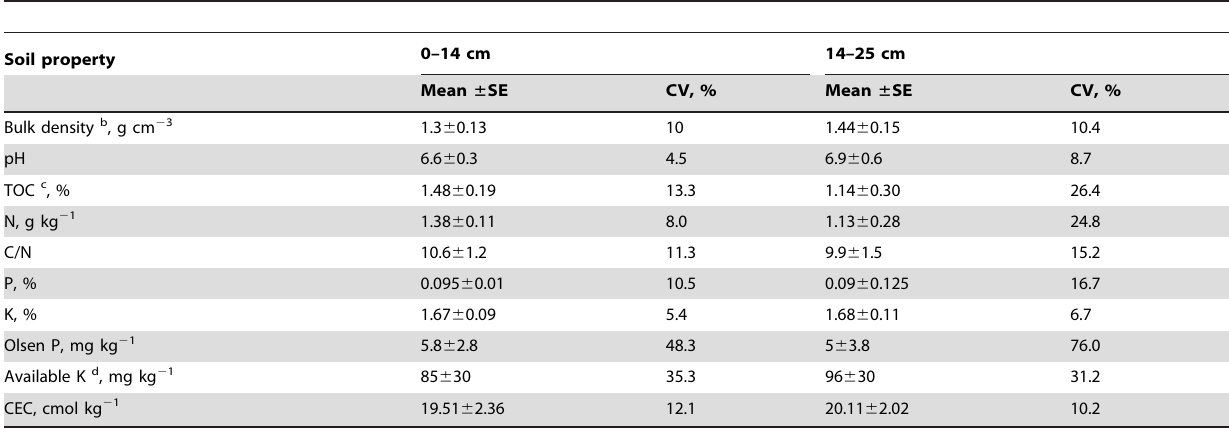
Table 2. Initial properties of the urban soil in Yixing obtained from the second Chinese soil survey a ( n = 9 except where noted).